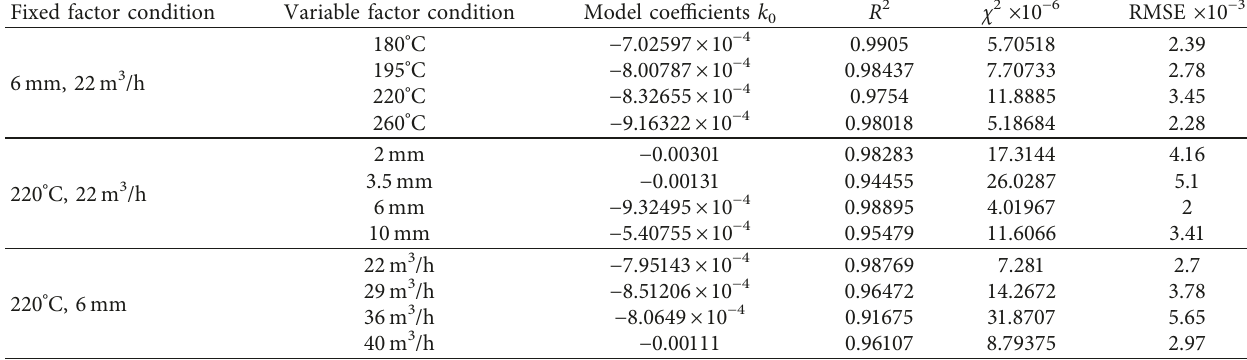
Table 3: Fitting results of restoration stage of sludge superheated steam drying under different drying conditions.